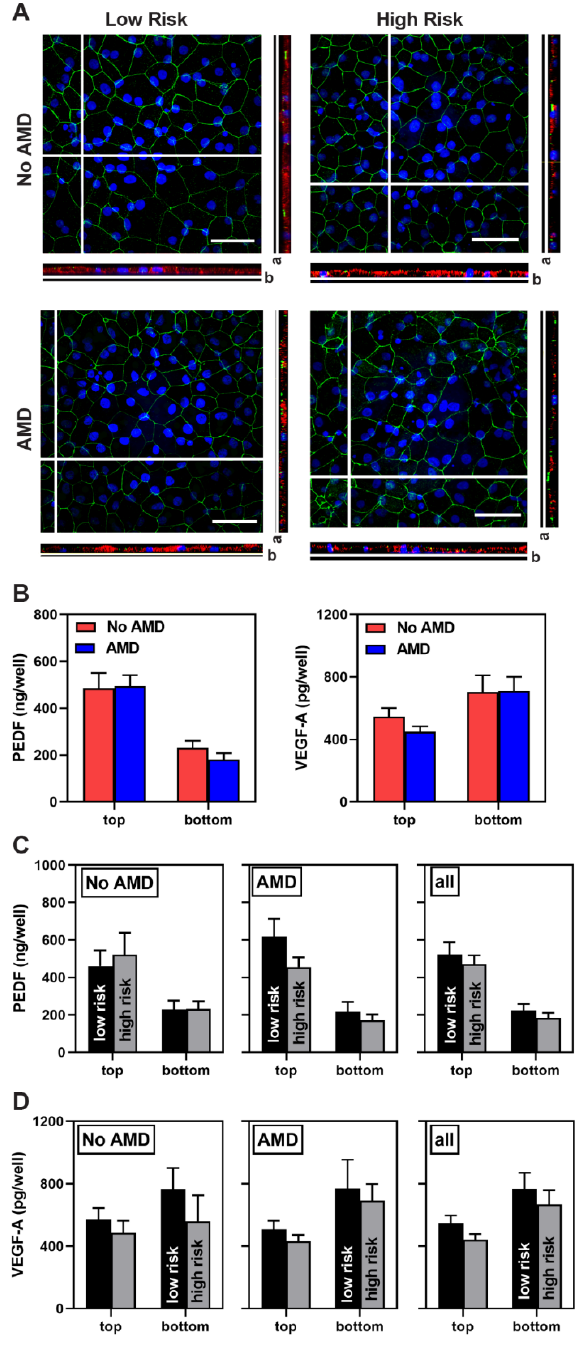
Figure 1. Characterization of iPSC-RPE derived from epithelial cells of the conjunctiva. ( A ) En Face views of the immunostained iPSC-RPE monolayer showing ZO-1 (green) marking cell borders and the orthogonal x-z views showing Bestrophin (red). Direction of the apical (a) and basal (b) side of the orthogonal image are indicated. Scale bar = 40 um. Nuclei are stained using DAPI (blue). ( B , C , D ) Results from ELISA analysis of PEDF and VEGF-A content measured in apical (top) and basal (bottom) media from iPSC-RPE grown in transwells. Data show results comparing ( B ) No AMD (7 donors, 10 lines) and AMD (12 donors, 17 lines) donors, and ( C , D ) donors genotyped for the CFH low-risk (No AMD 4 donors, 6 lines; AMD 3 donors, 4 lines) and CFH high-risk (No AMD 3 donors, 4 lines; AMD 9 donors, 13 lines) alleles. PEDF = pigment epithelium-derived factor, VEGF-A = vascular endothelial growth factor A. Data are presented as mean ± SEM. Unpaired t-tests was used to compare data from No AMD to AMD (B) or high- to low-risk ( C , D ). All comparisons were not statistically